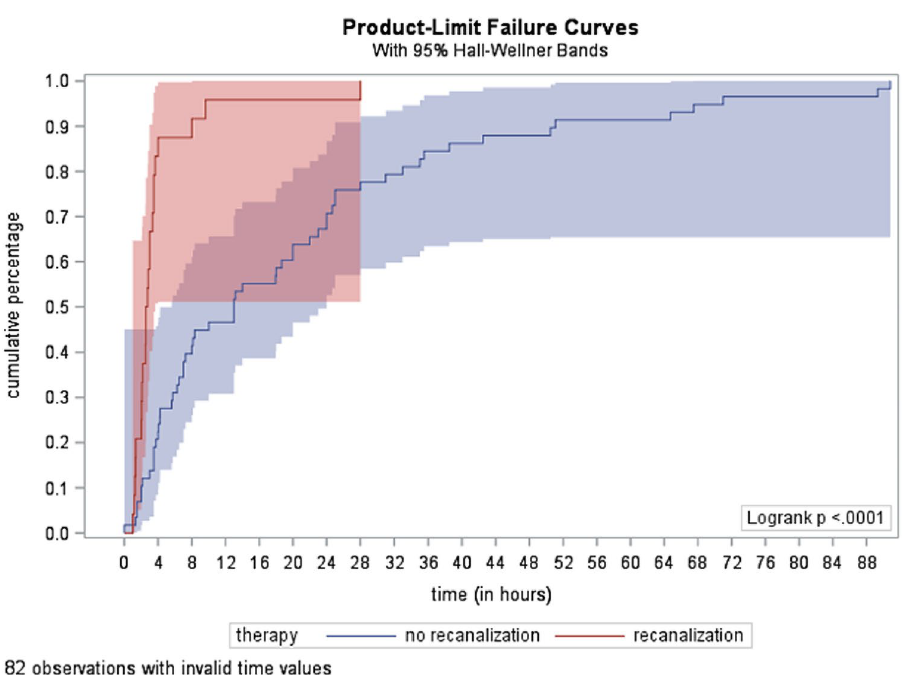
Figure 1. Time from symptom onset to diagnosis. Comparison of the exact time (in h) from the symptom onset to confirmation of diagnosis in the non-RT (n = 28) and RT groups (n =